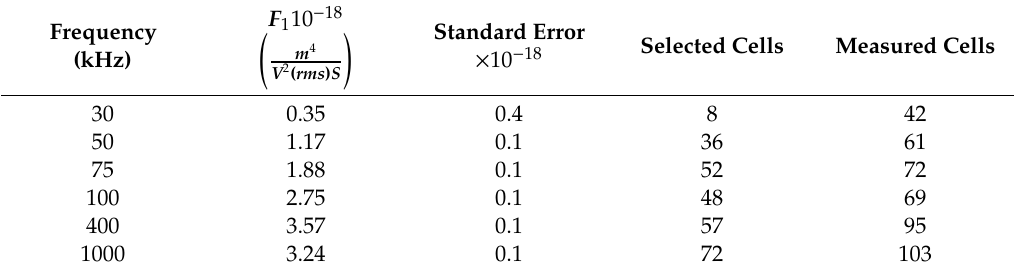
Table 3. F 1 parameter measurements. Collected values for single cells.